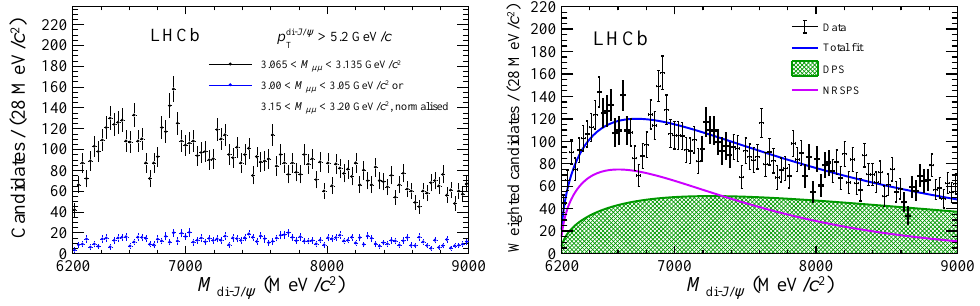
Figure 1: Data on the double- J /ψ production in proton-proton collisions provided by the LHCb Collaboration (left plot) superposed with the non-resonant distributions (right plot) where NRSPS and DPS stand for the NonResonant Single Parton Scatter- ing and Double Parton Scattering, respectively. Adapted from Ref. [ 1 ] .